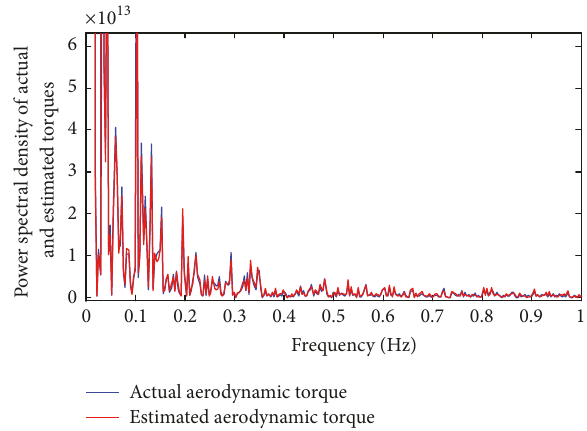
Figure 3: The actual and estimated aerodynamic torque.